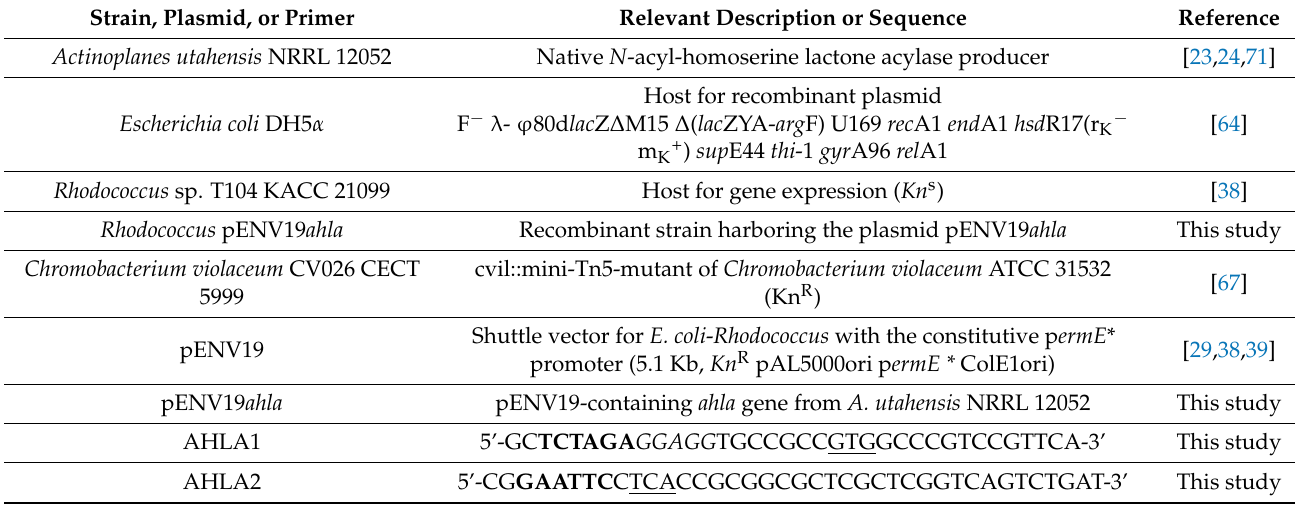
Table 3. Bacterial strains, plasmids, and primers #